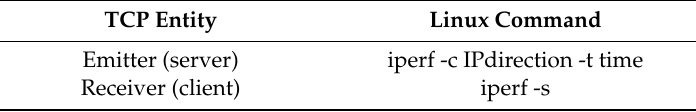
Table 2. IPERF Configuration